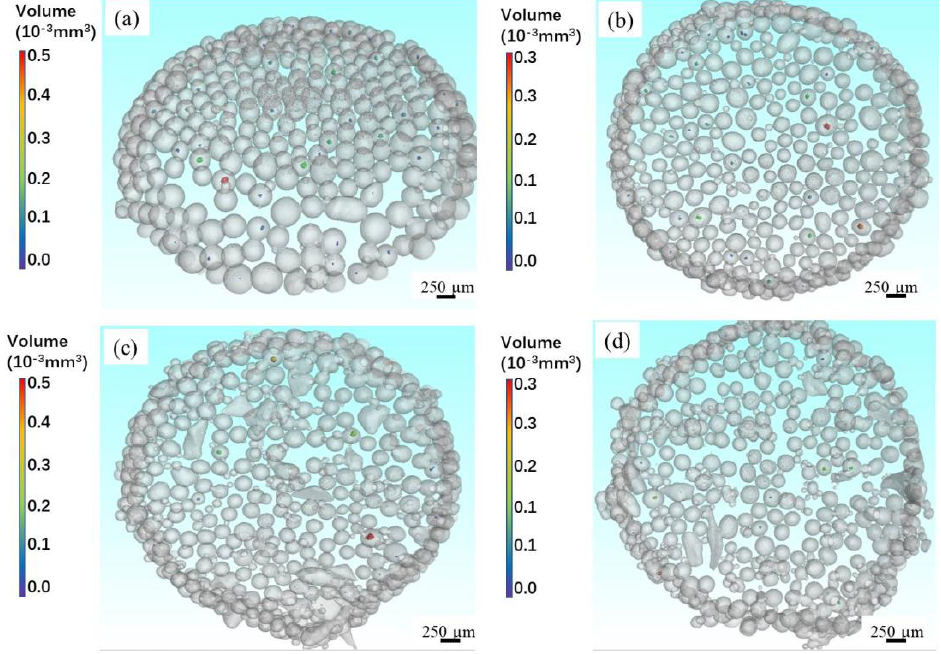
Figure 5. The 3D reconstructed CT of Ti-6Al-4V powders at ( a ) 8000 RPM, ( b ) 10,000 RPM, ( c ) 12,000 RPM, ( d ) 14,000 RPM.